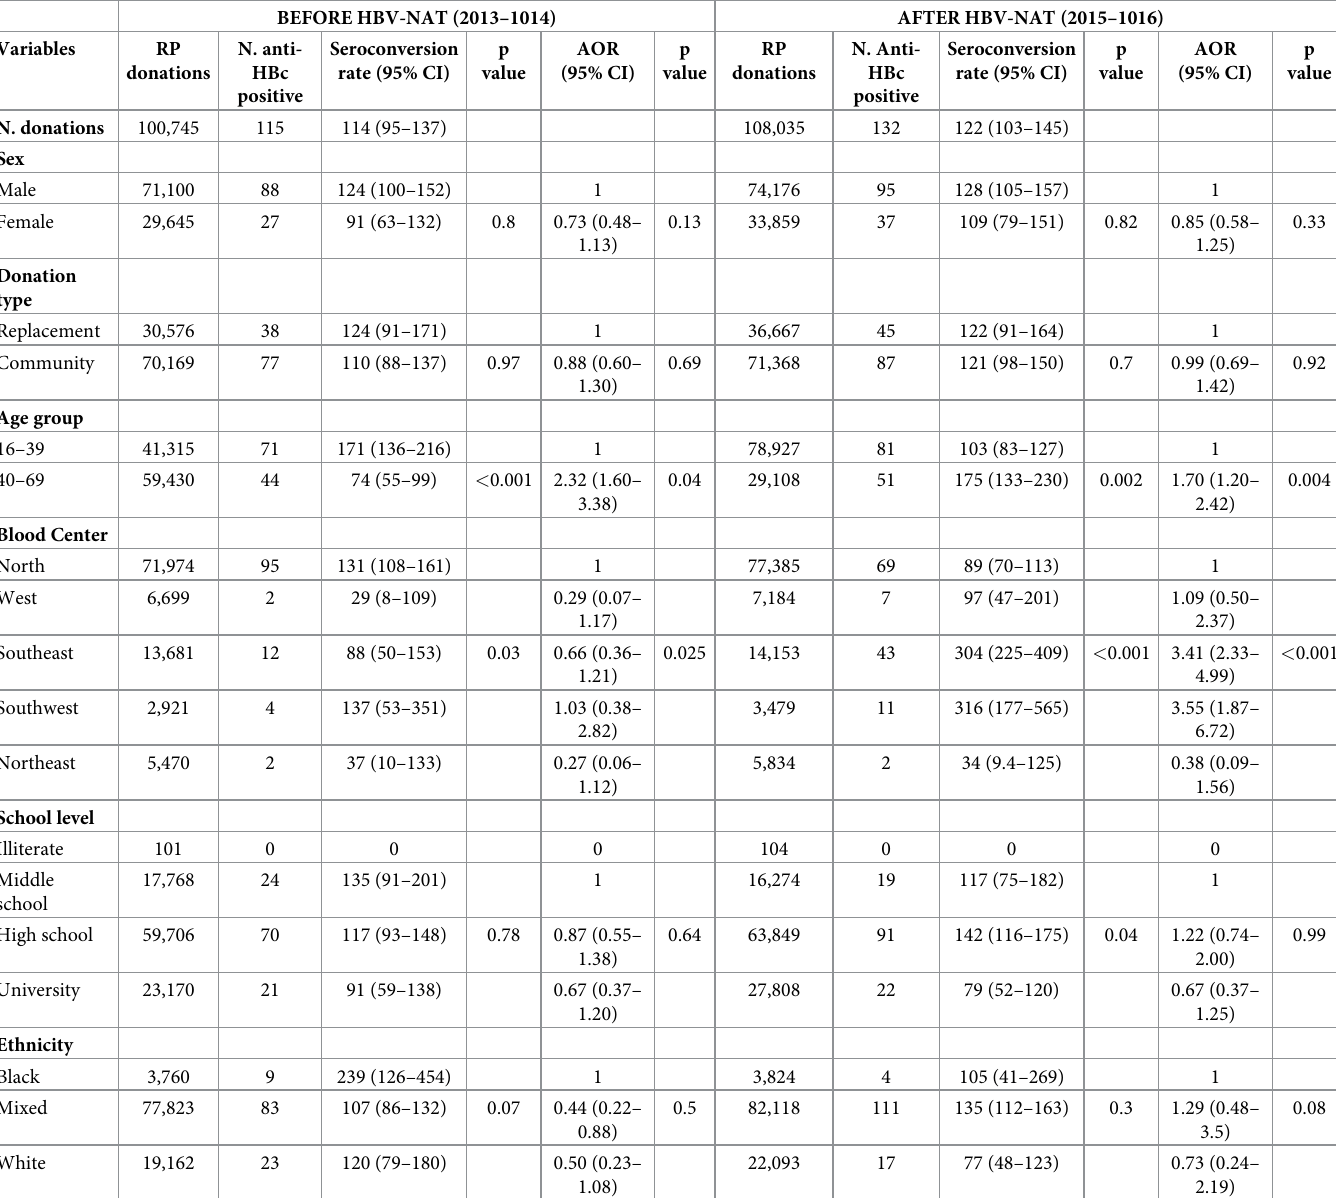
Table 3. Seroconversion rate of HBV infection per 100,000 donations in Para´ state of Brazil, before and after HBV-NAT